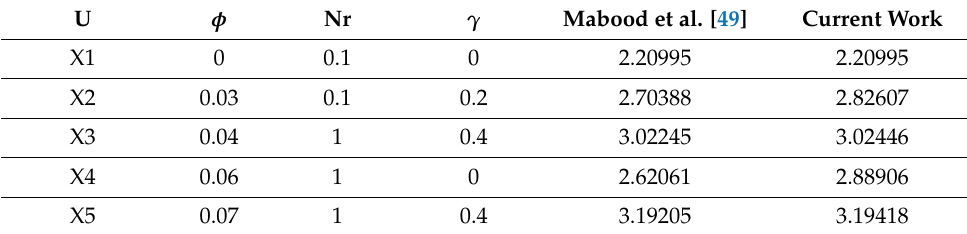
Figure 7. Impact of the radiation parameter (Nr) on the Temperature. Table 7. Comparison of the local Nusselt number Nu x for various values of φ , Nr, γ